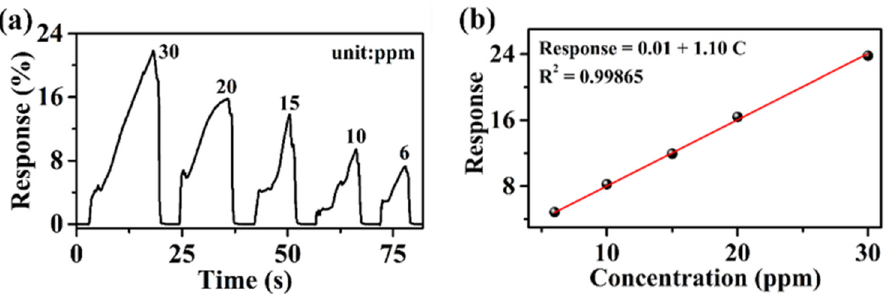
Figure 7. ( a ) Response curves of the sensor 6 − 3H to di ff erent concentrations of H 2 O 2 ; ( b ) the fitting plots of response Vs concentration of H 2 O 2 .